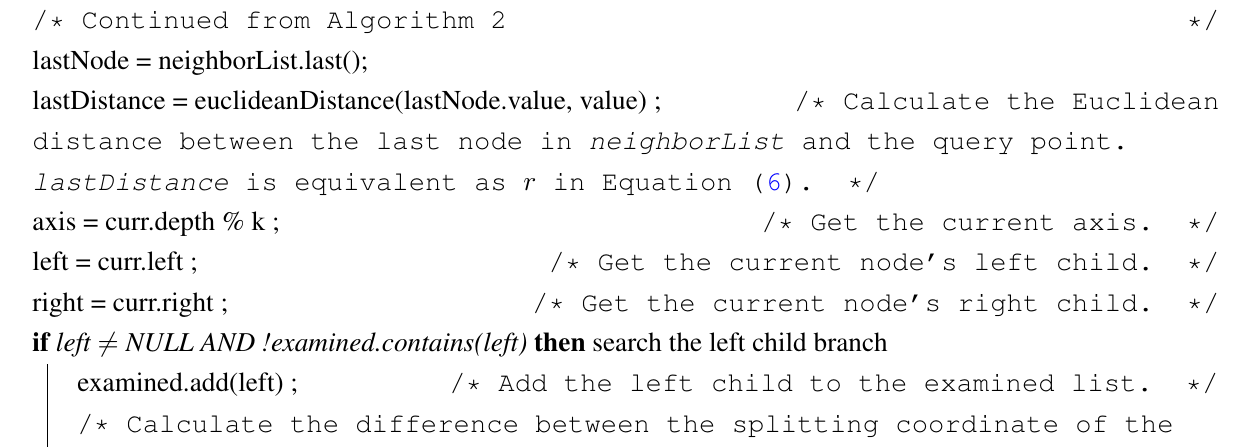
Algorithm 3: searchNode(value, curr, k, neighborList, examined), Part II /* Continued from Algorithm